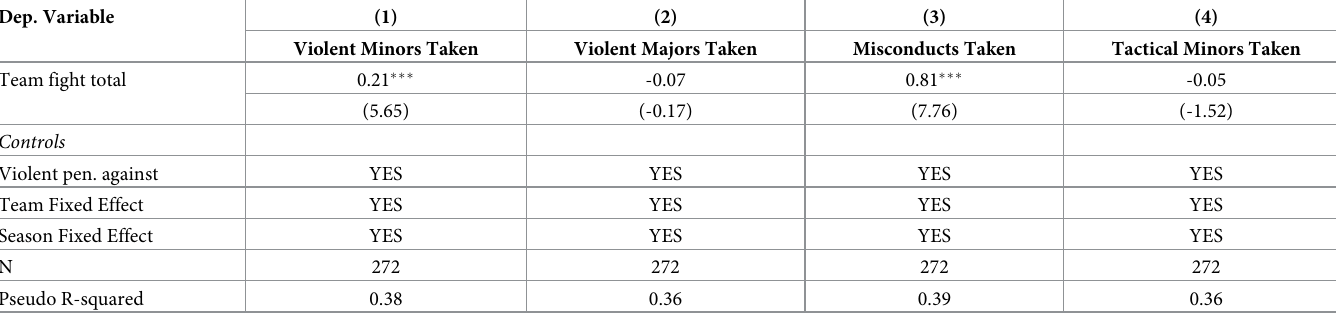
Table 3. Marginal effect of season violent penalties on season fights. Dep.